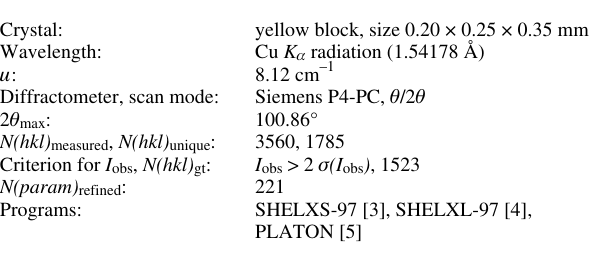
Table 1. Data collection and handling.